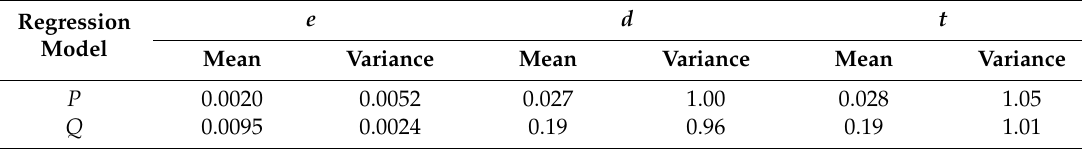
Table 5. Statistical results of Multiple Types of Residuals.